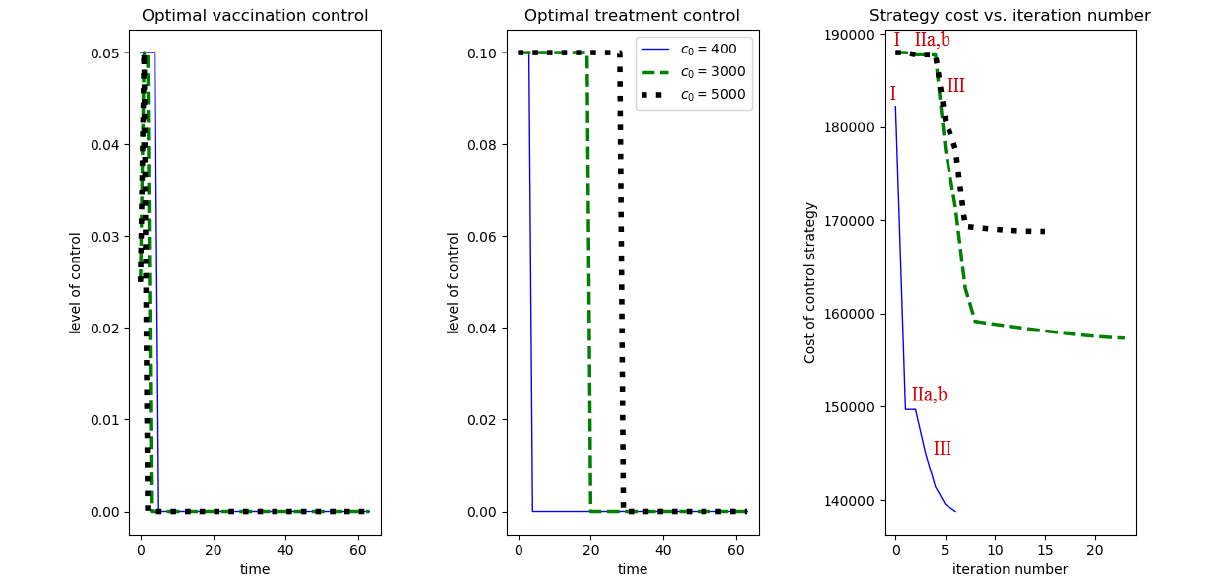
Figure 8. Optimal vaccination, treatment controls and strategy cost for different values of c 0 .